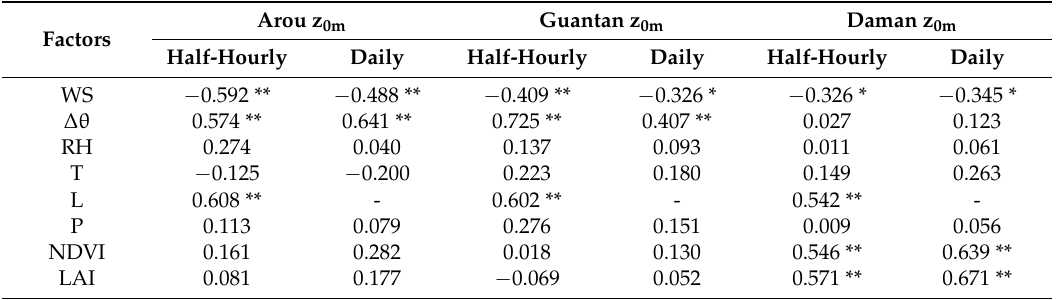
Table 2. The correlation coefficients ( R ) between half-hourly z 0m , daily z 0m and possible driving factors.